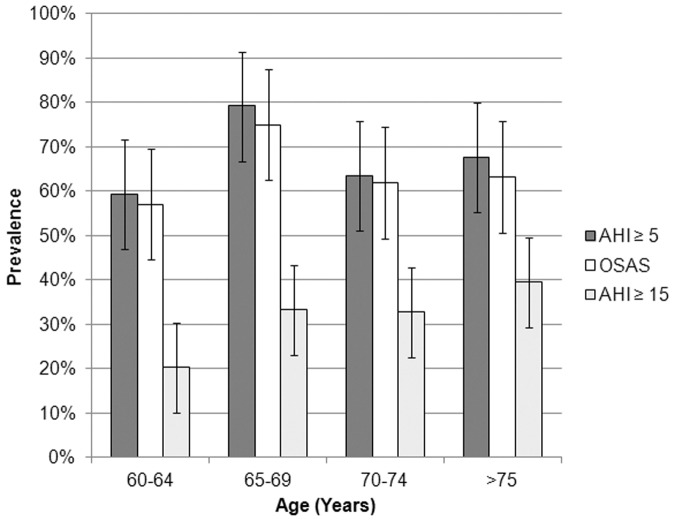
OSAS prevalence estimates with 95% confidence intervals are illustrated based upon AHI cutoffs of 5 and 15, and diagnosis of OSAS according to age quartile.